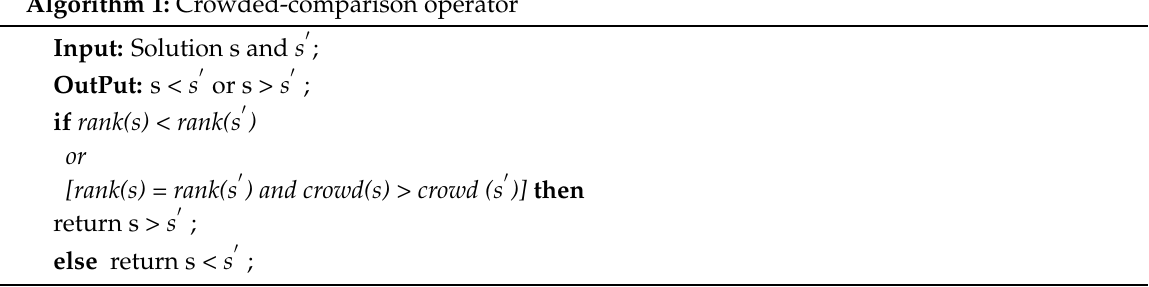
Algorithm 1: Crowded-comparison operator